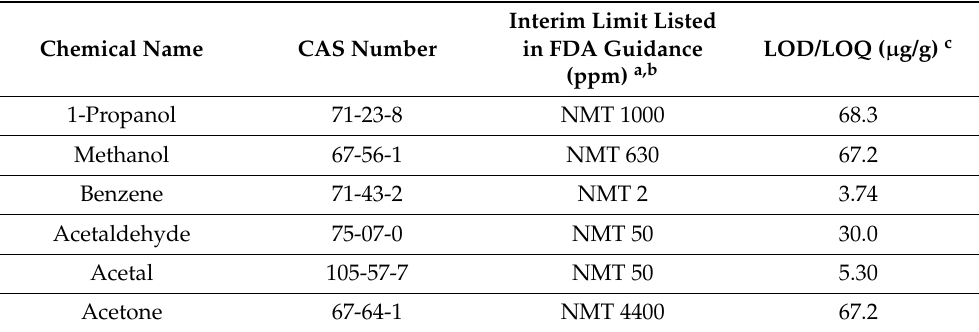
Table 2. List of FDA Interim Limits and Limits of Detection/Limits of Quantification (LODs/LOQs) for Impurities Assessed in Hand Sanitizers Marketed to